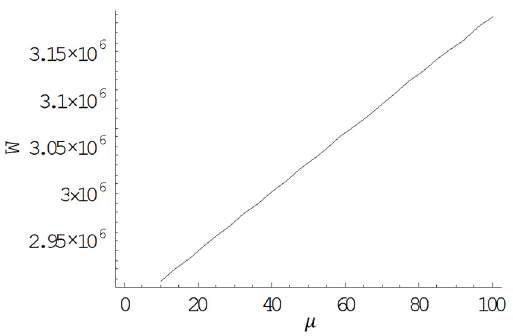
Figure 12. Total cost versus parameter µ .